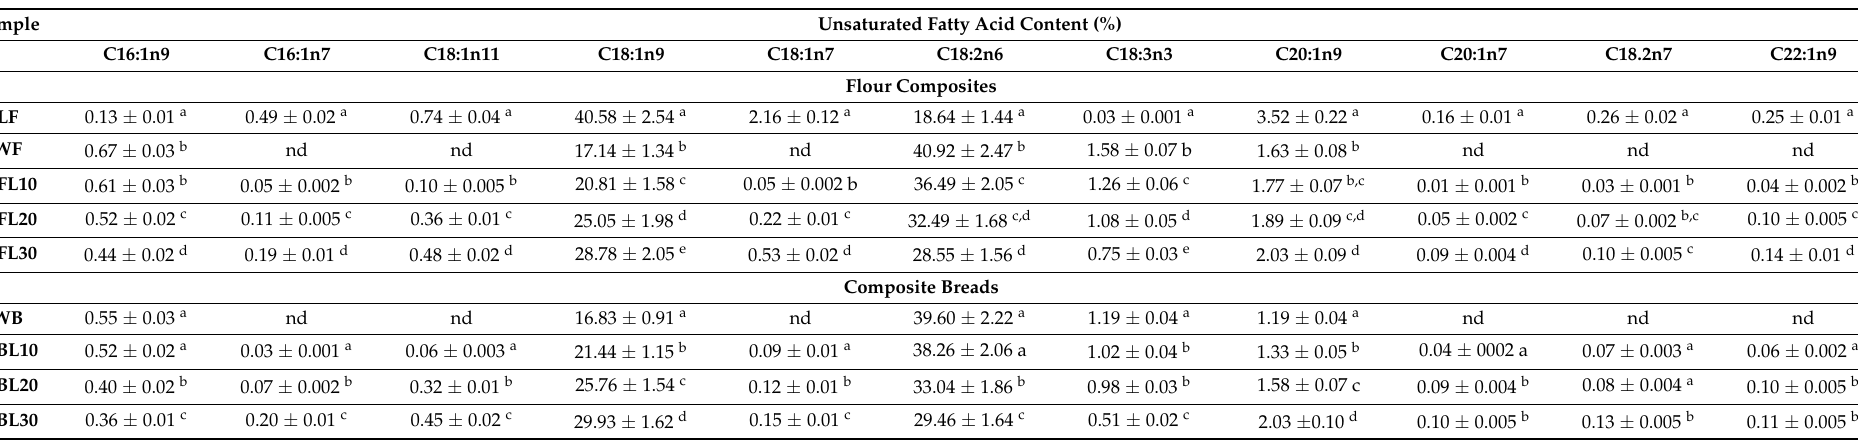
Table 6. Unsaturated fatty acid (UFA) composition of sample expressed as % of total fatty